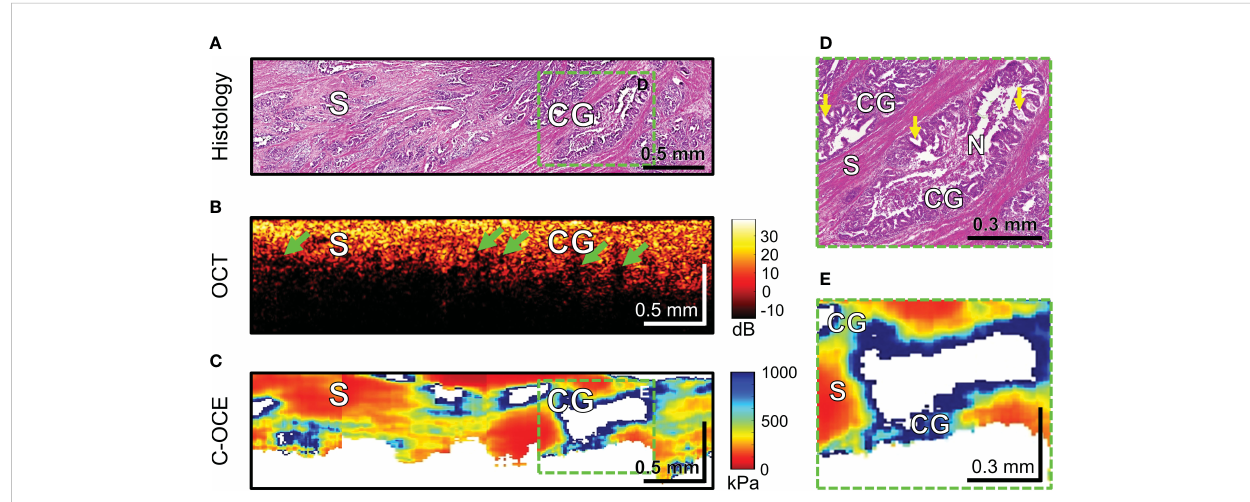
FIGURE 8 Example of morphological examination of colorectal adenocarcinoma with cribriform pattern tissues by C-OCE: cribriform gland-like structures [CG] characterized by high stiffness values (724 ± 86 kPa) and located among stroma [S] having lower stiffness (295 ± 120 kPa). Comedo necrosis [N] was not detected by C-OCE due to its free presence in the gland-like structures ’ lumen. Corresponding tissue areas in histological (A) , OCT (B) and C-O С E (C) images. Green arrows in panel B indicate faintly visible areas of signal loss associated with a large lumen of cribriform gland-like structures. Enlarged areas of cribriform gland-like structure on histological (D) and C-O С E (E) images demonstrate nodular nests with ‘ punched out ’ spaces (yellow arrows) as well as intraluminal bridging. Bar size is shown in the images.